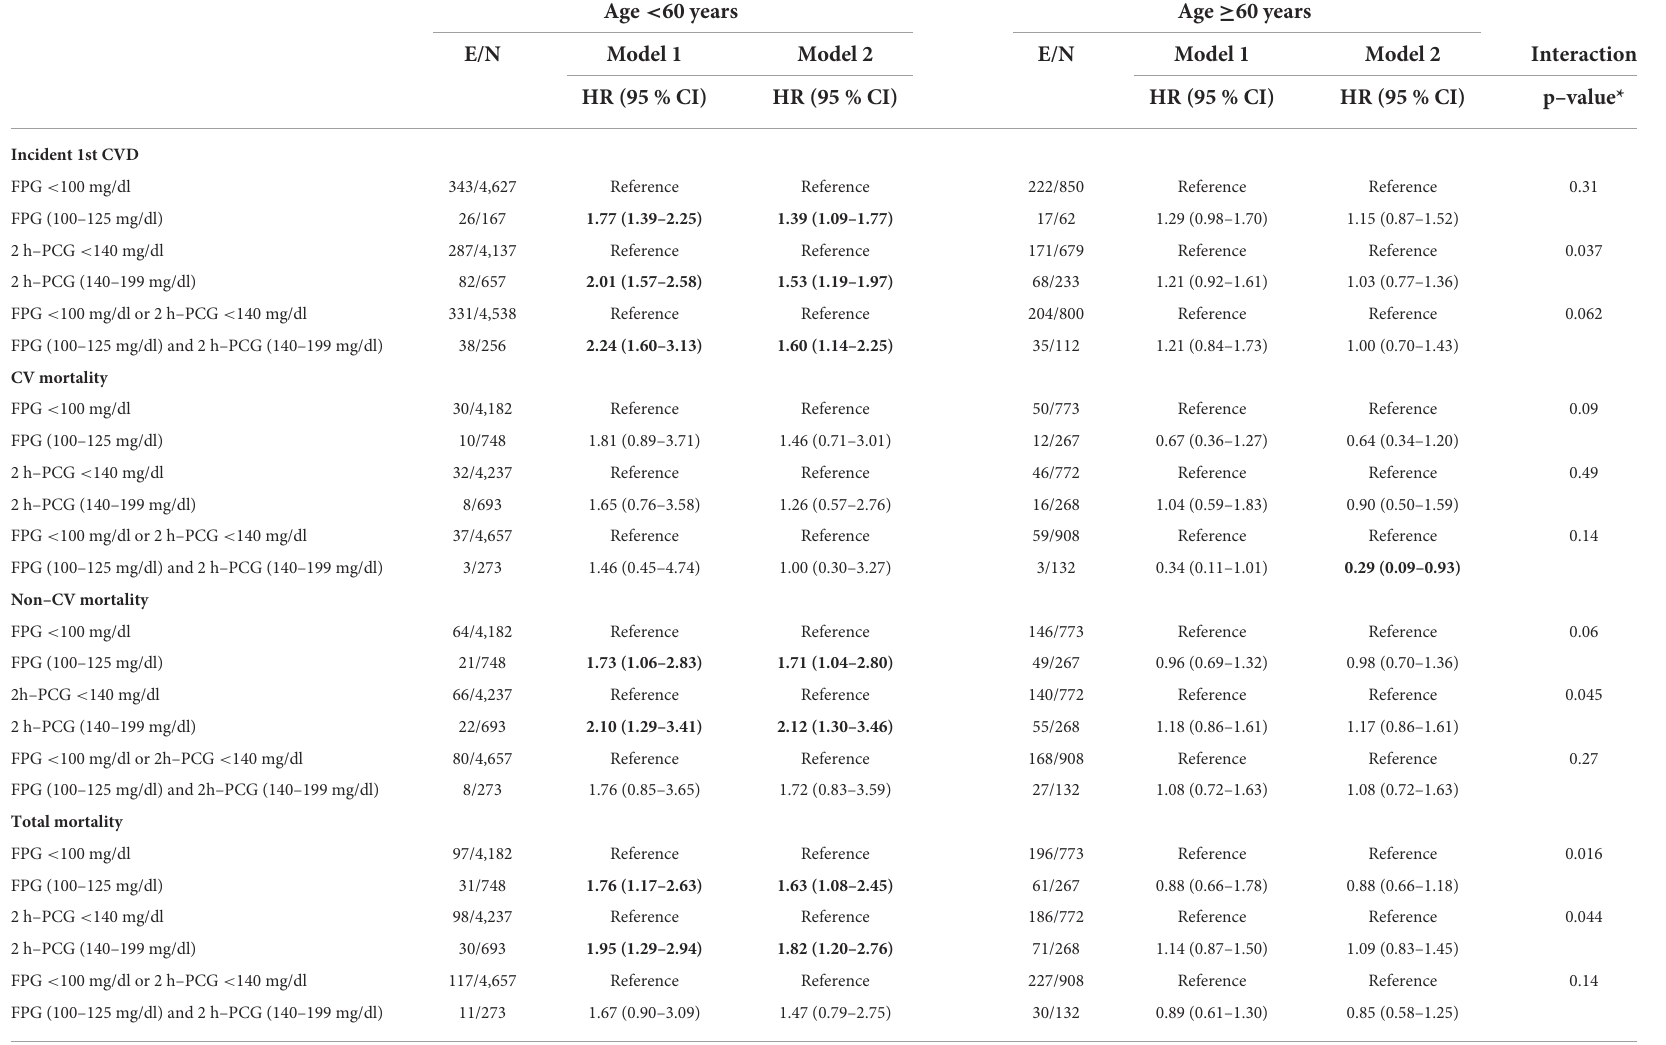
TABLE 3 Adjusted hazard ratios (95 % CI) for incident CVD, CV mortality, and total mortality by age groups: Tehran lipid and glucose